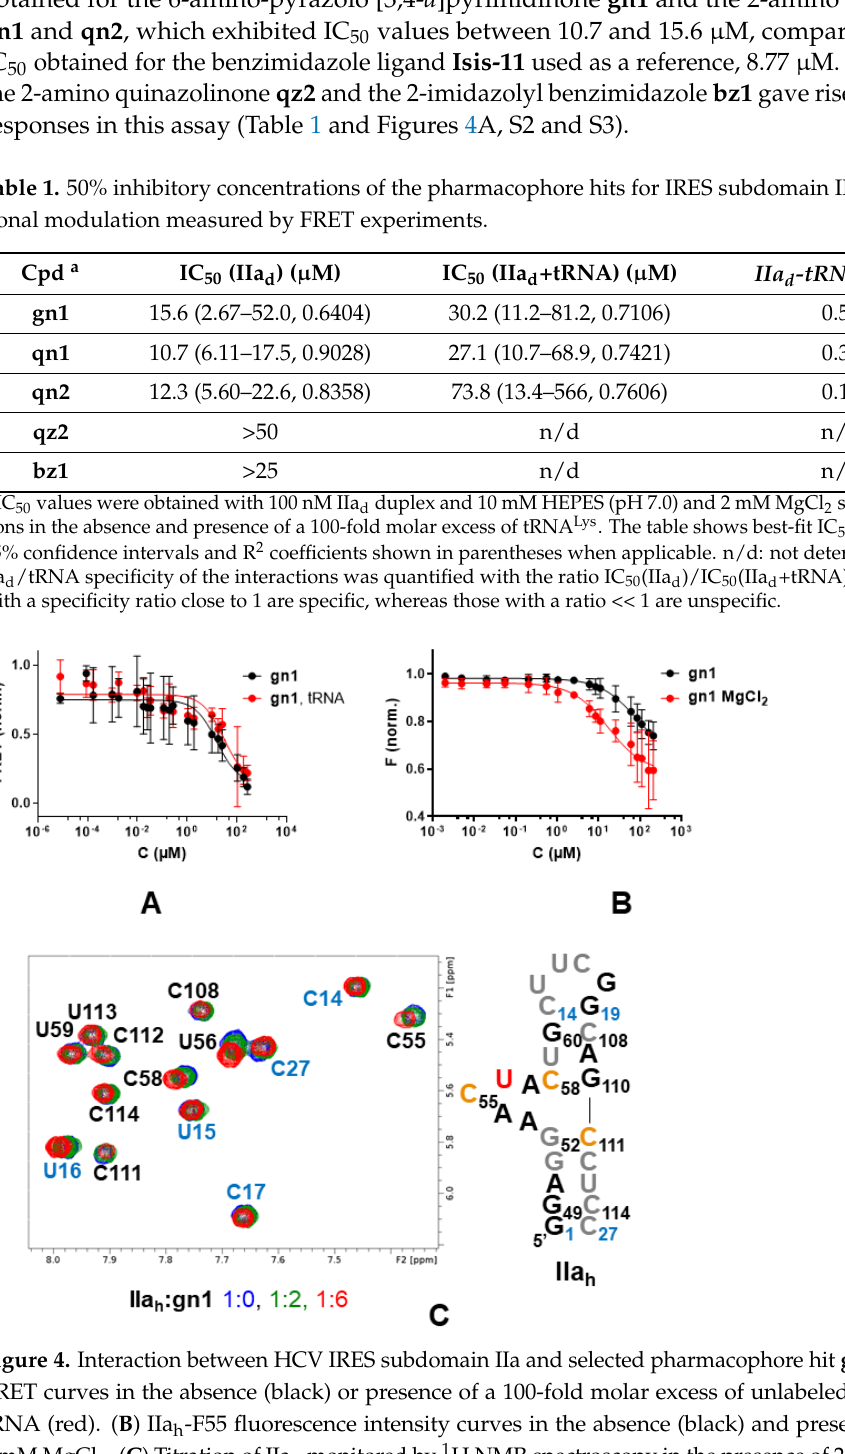
Figure 3. Chemical structure of the five pharmacophore screening hits evaluated in this study. The